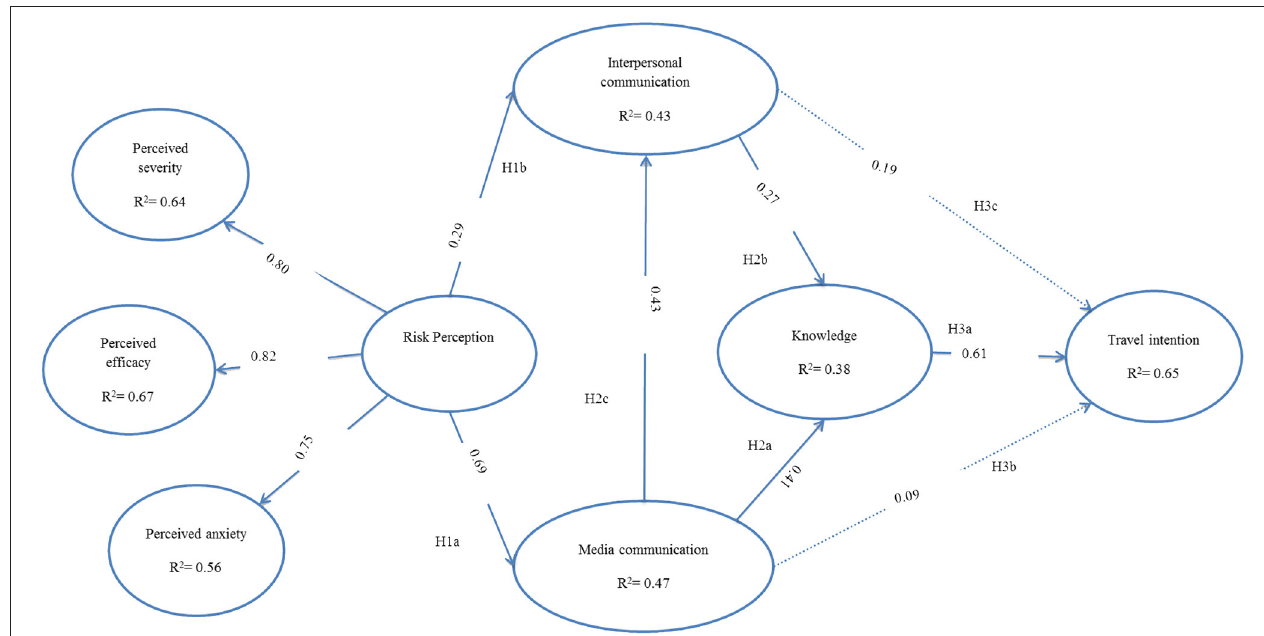
FIGURE 2 | A structural equation model and path